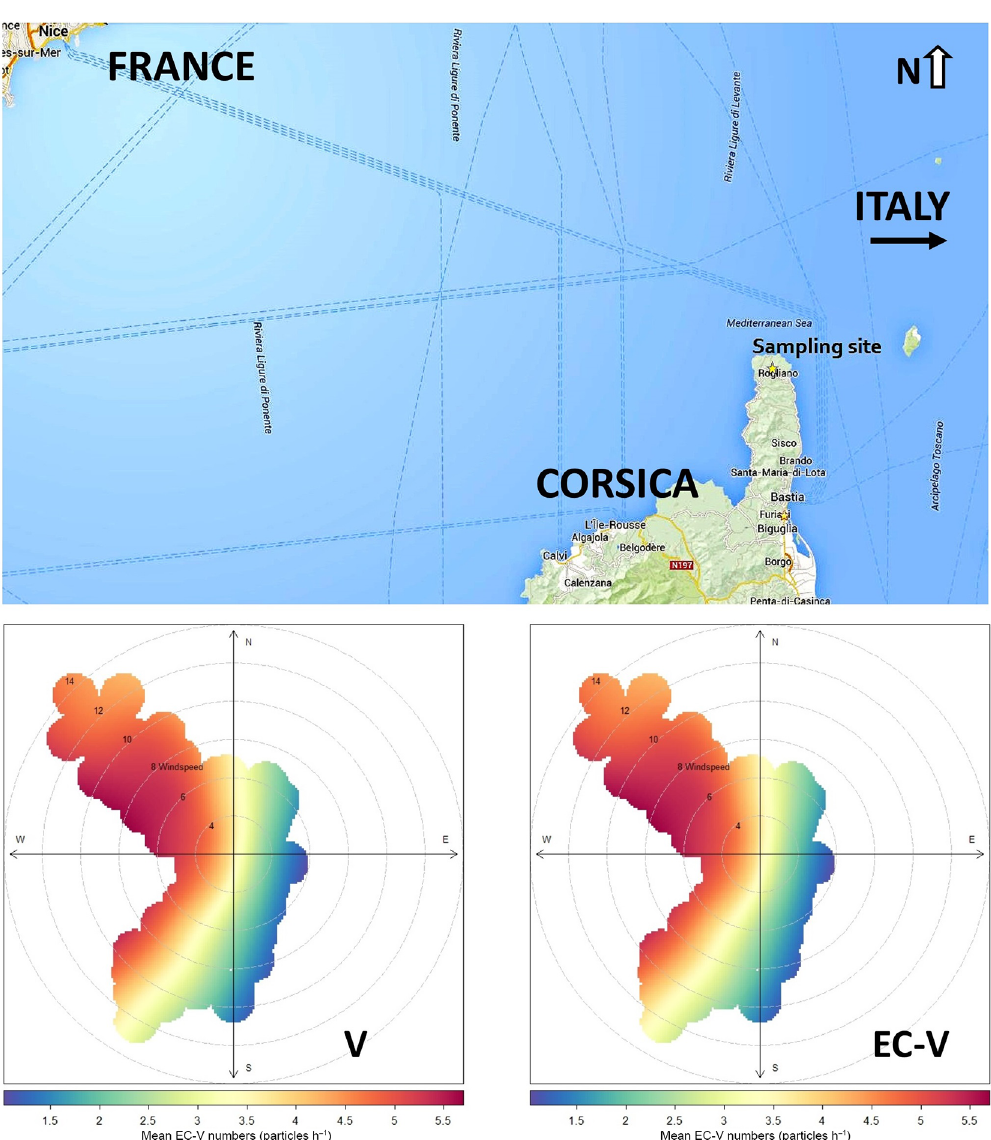
Figure 10. Passenger ferry lanes around the sampling site on Corsica (top) and wind speed and direction dependences (bottom) for ATOFMS V-rich particles observed during ADRIMED and